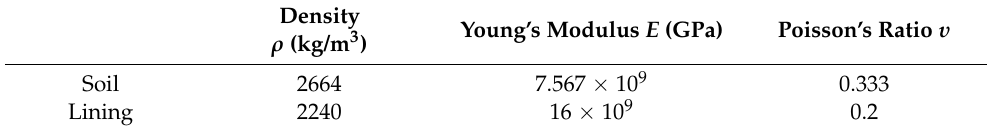
Figure 8. P–SV wave with longitudinal scattering by tunnel in a homogenous half space: ( a ) 2.5D substructure model and ( b ) top view of substructure model. Table 2. Site